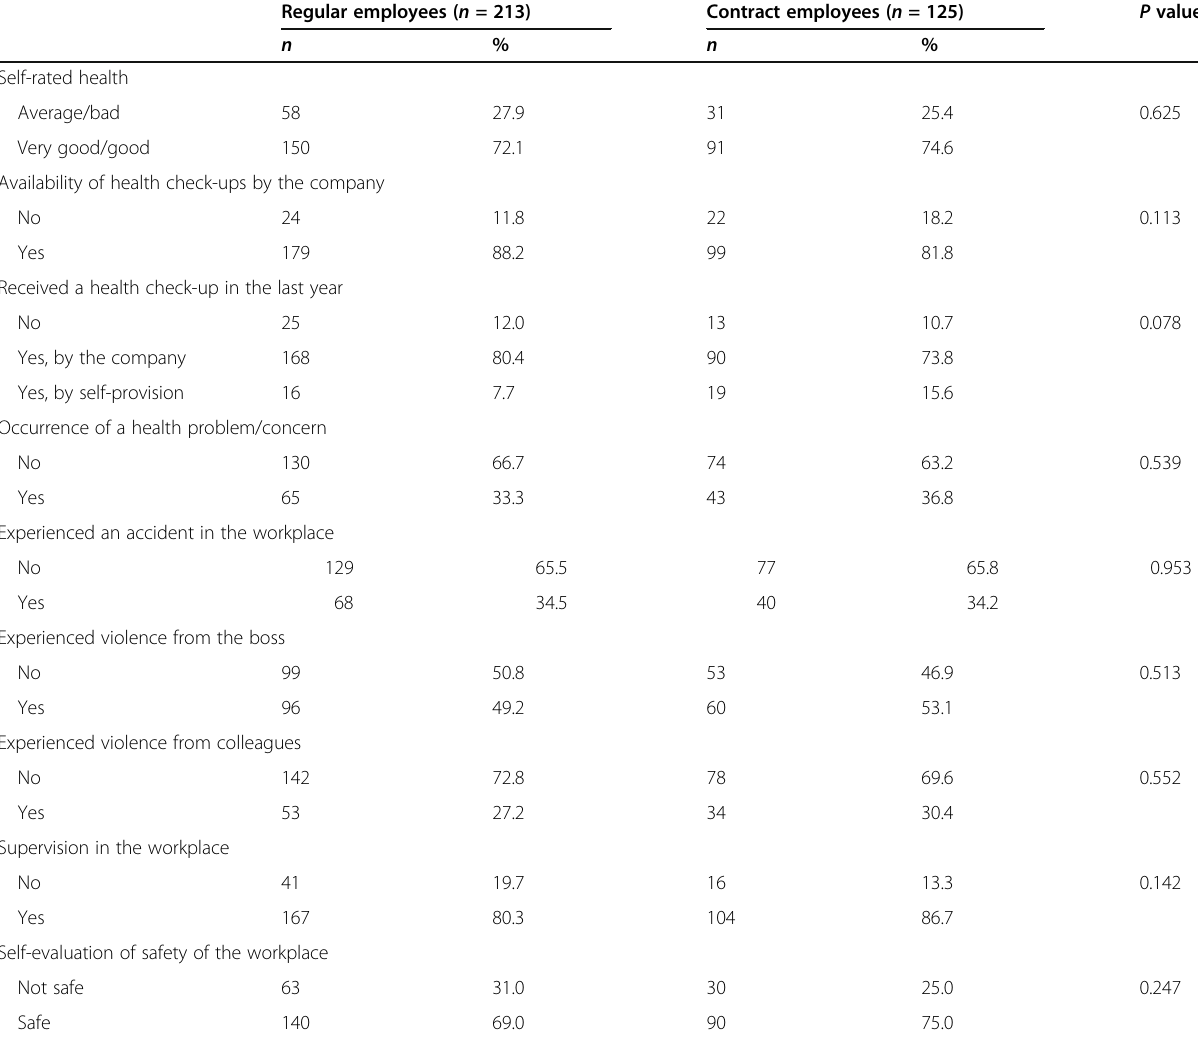
Table 3 Health conditions and health- and safety-related conditions in the workplace ( n = 330) Regular employees ( n =